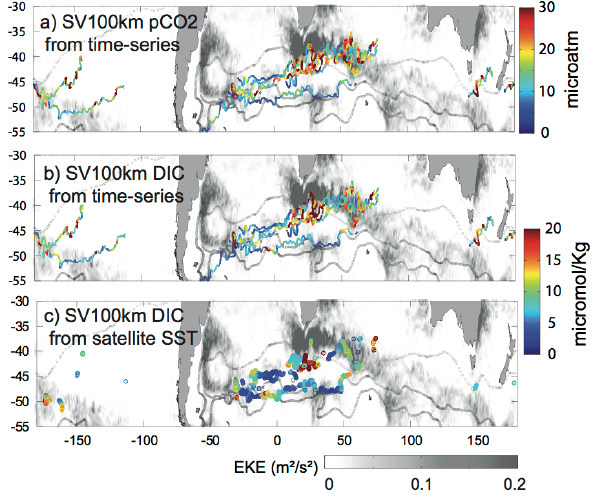
Fig. 3. Eddy kinetic energy (EKE, grey scale) estimated from satel- lite altimetry and mesoscale variability (a) SV100km of in situ p CO 2 (in µatm) and (b) SV100km of in situ DIC (in µmolkg − 1 ) estimated from the standard deviation of high-pass filtered fields in 100km × 100km boxes along drifters trajectories (see Sect. 3.1.2 for further details), (c) SV100km sat of DIC (in µmolkg − 1 ) recon- structed from satellite SST and the local linear correlations between SST and DIC deduced from drifters data. DIC was reconstructed only for correlation coefficients r 2 > 0. (Fig. 8), hence explaining the lower spatial coverage of panel (c) compared to panel (b) . EKE was estimated in 2006 from satellite altimetry as (u − u) 2 + (v − v) 2 , where u and v are the zonal and meridional surface current veloci- ties and the overbear denotes the annual